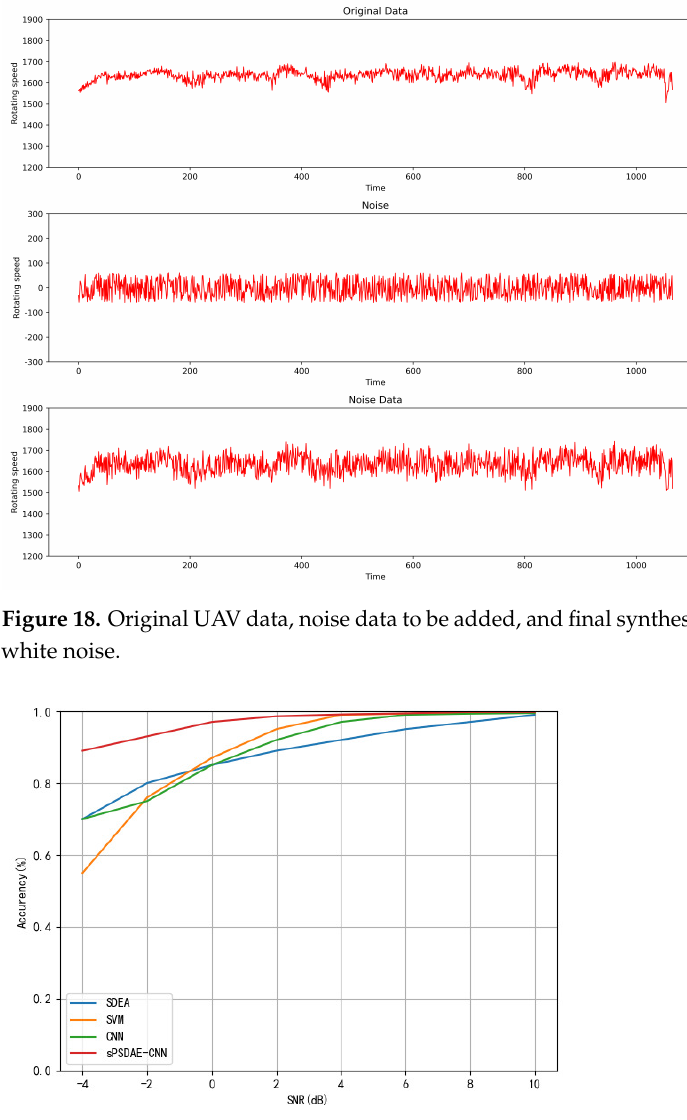
Figure 19. Comparison of accuracy of different fault diagnosis algorithms under different noise